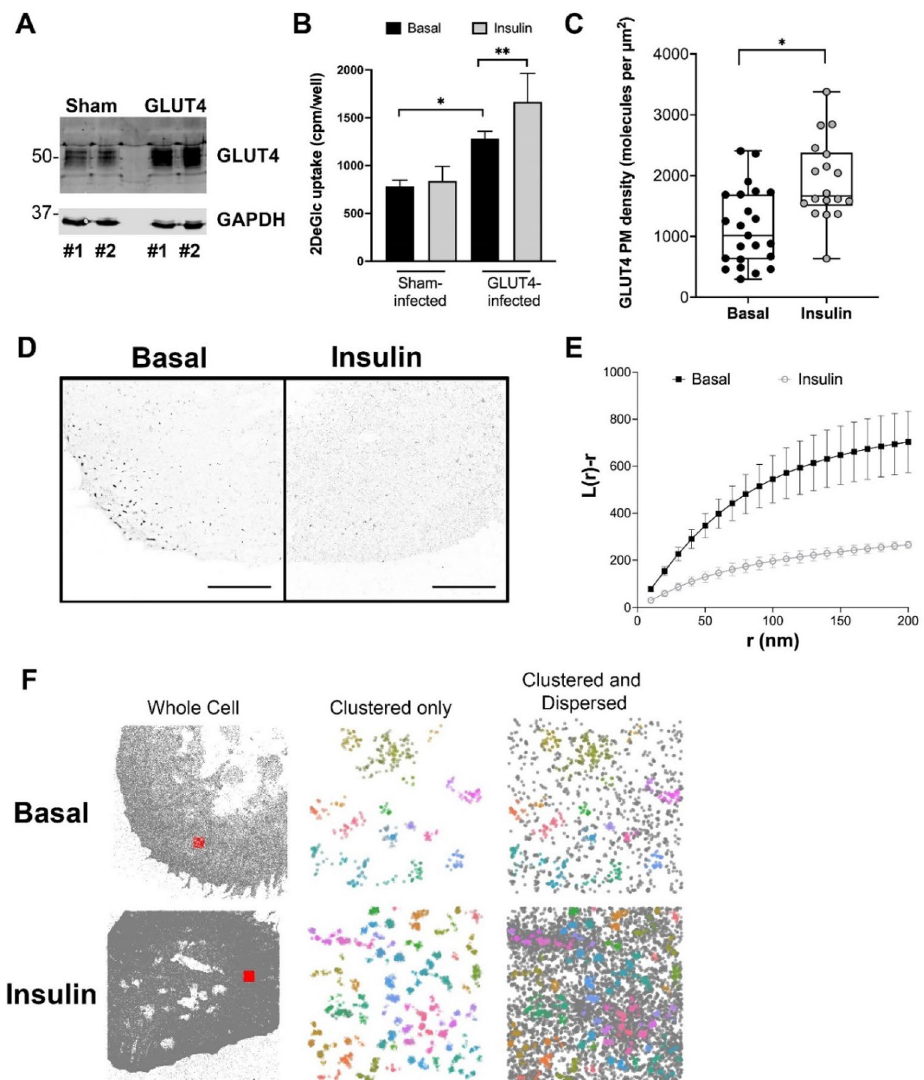
Figure 1. Behaviour of GLUT4 in iPSC-cardiomyocytes. ( A ) We over expressed human GLUT4 using lentivirus in iPSC-CMs. Shown are two representative examples (#1 and #2) of empty virus infected cells (‘Sham’) and cells infected with GLUT4 virus (‘GLUT4’). Lysates were immunoblotted for GLUT4 and GAPDH and increased levels of GLUT4 are evident in GLUT4-virus infected cells. Levels of over-expression ranged from 2- to fourfold between experiments. ( B ) Deoxyglucose (DeGlc) uptake was assayed in the presence and absence of insulin in parallel batches of virus infected cells. Data shown is from three independent biological replicates. GLUT4 overexpression increased basal glucose transport (*p = 0.01), and cells overexpressing GLUT4 exhibited insulin-stimulated glucose transport (**p = 0.05). Sham-infected cells did not exhibit insulin-stimulated glucose transport. Statistical analysis was performed using an unpaired t-test on raw data. ( C ) We expressed HA-GLUT4-GFP in iPSC-CMs and quantified localisation density of cell surface GLUT4 (as HA staining) before and after stimulation with 100 nM insulin for 20 min. The data from replicate experiments is presented as a box and whiskers plot, each point represents data from a single cell. Insulin stimulated a 1.7-fold increase in cell surface HA staining, *p = 0.0005 by unpaired two sample t-test. ( D ) Representative images of iPSC-CMs expressing HA-GLUT4-GFP stained for HA as outlined. Scale bars = 10 μm. ( E ) GLUT4 molecule coordinates were obtained using ThunderSTORM and their spatial pattern was analysed using normalized Riley’s K function (L(r)), derived from the Voronoï diagram of GLUT4 molecule coordinates. L(r) describes how many segmented clusters can be found within a distance r of any arbitrary point. Empirical estimates of L(r) are shown for basal and insulin-stimulated cells. The experiment was carried out independently on > n = 10 cells per group and the basal and insulin values differed significantly (p < 0.0001; determined by unpaired two samples t-test). ( F ) GLUT4 molecule coordinates were processed using a python HDBSCAN script written in house. Gray dots indicate single molecule localizations for representative whole cells (left panels). Representative 4 μm × 4 μm ROIs are highlighted by the red squares. The middle panels show coloured molecule clusters identified by HDBSCAN (‘clustered only’) and coloured clusters plus gray non-clustered molecules (‘clustered and non- clustered’, right panels) within representative